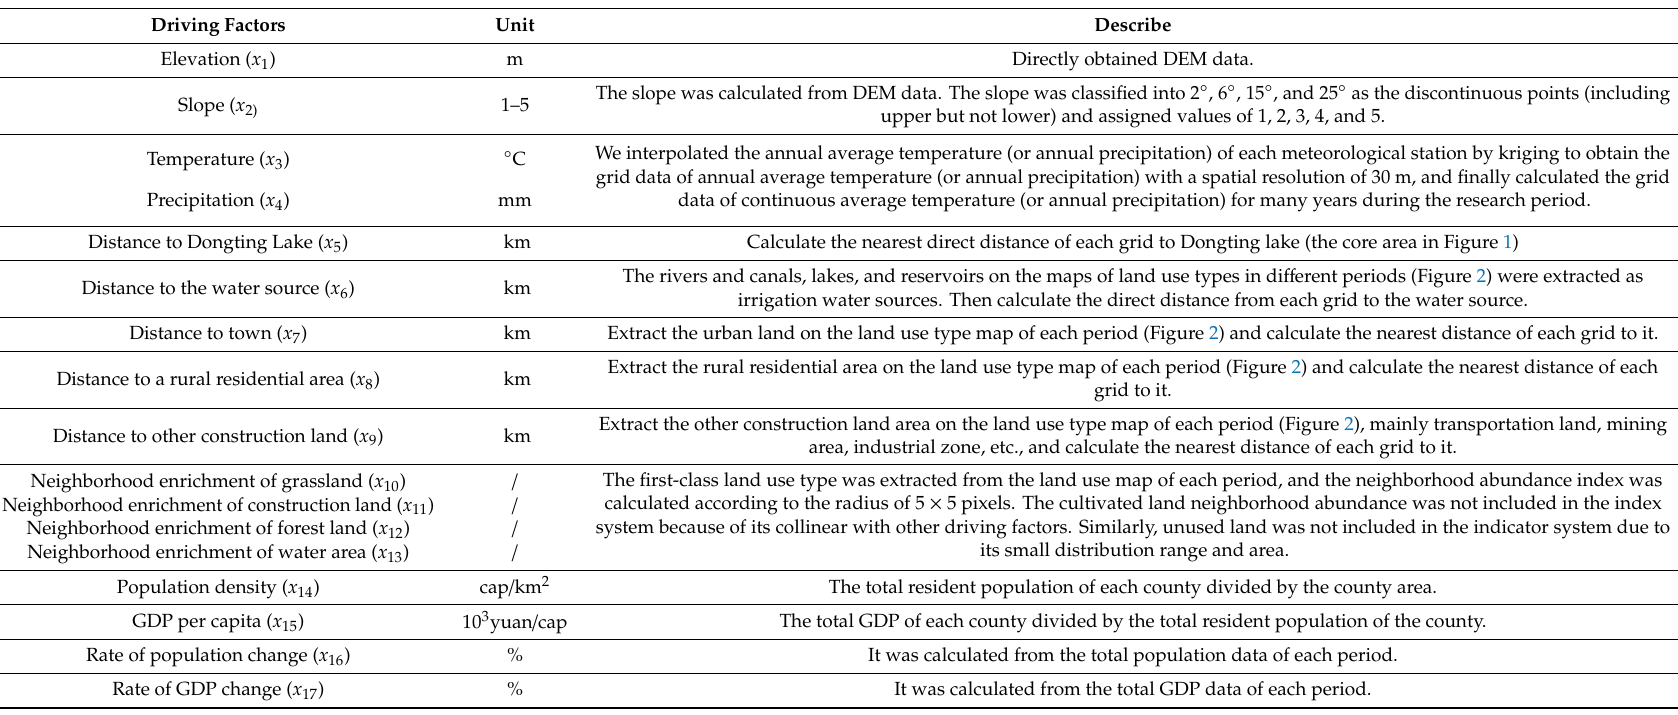
Table 1. Driving factors of cultivated land